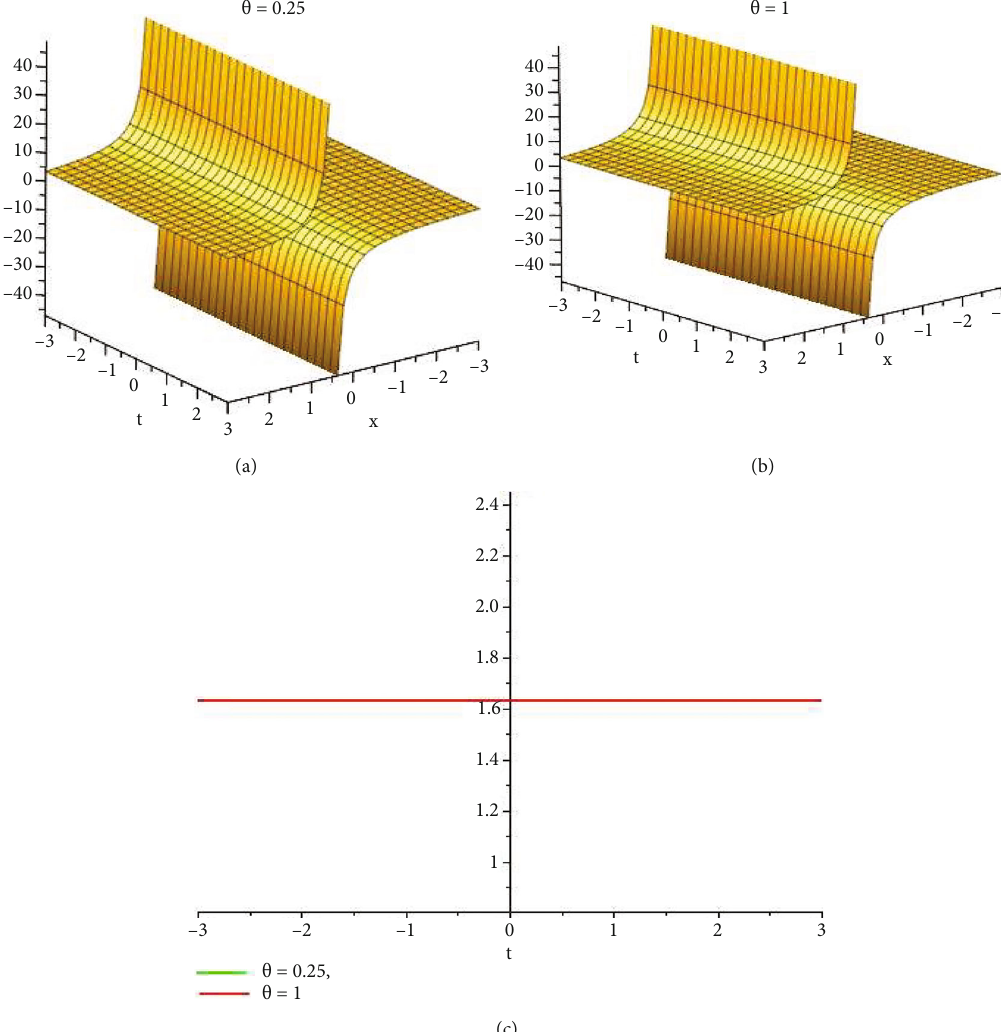
, y , t Þ . (a, b) 3D plot and (c) 2D combined plot for x = 1 5 ð x